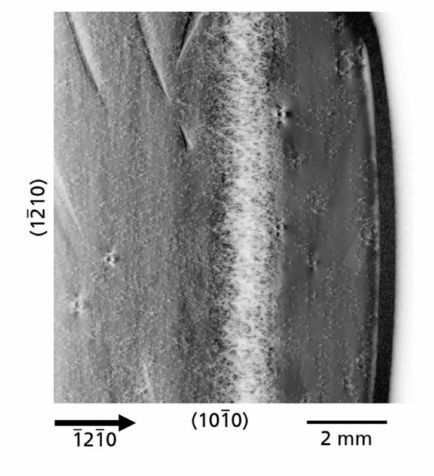
Figure 10. XRT image using 1210 reflection with a wall of a dense dislocation network observed in crystal A. The Borrmann effect is nearly extinct for this highly defective